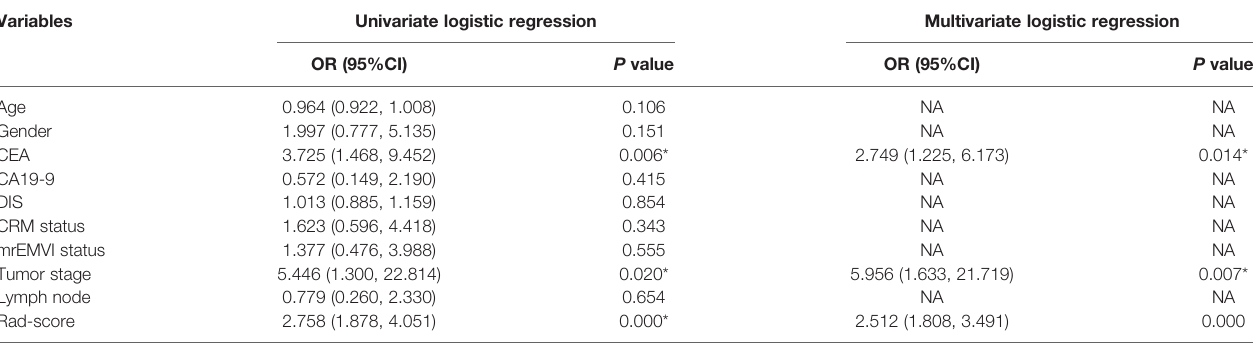
TABLE 3 | Results of univariate and multivariate logistic regression analyses.